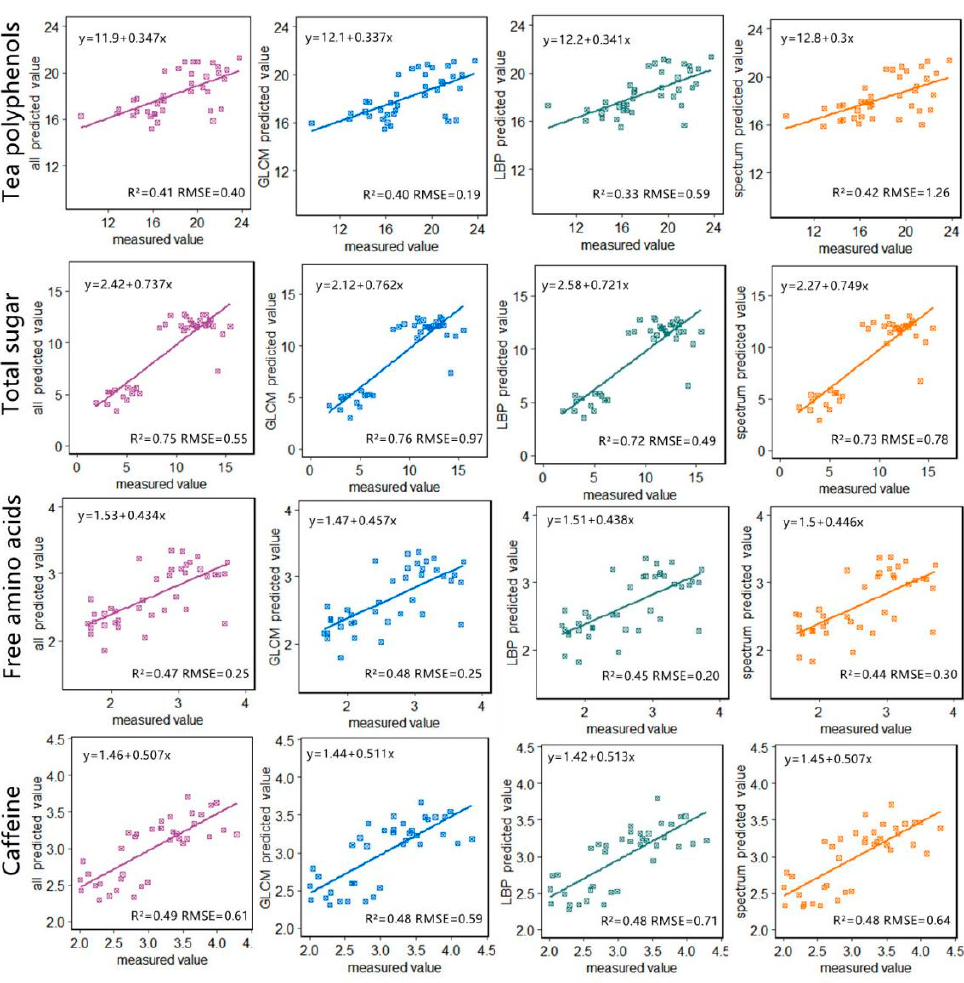
Figure 11. Effect of texture features on regression results for tea polyphenols, total sugar, free amino acids, and caffeine. The spectrum represents the near-use spectral features to be included in the regression, GLCM represents the addition of GLCM texture features based on spectral features to be included in the regression, and LBP represents the addition of LBP texture features based on spectral features to be included in the regression. The graphs represent the addition of GLCM and GLCM based on the spectral features. LBP texture features were included in the regression.